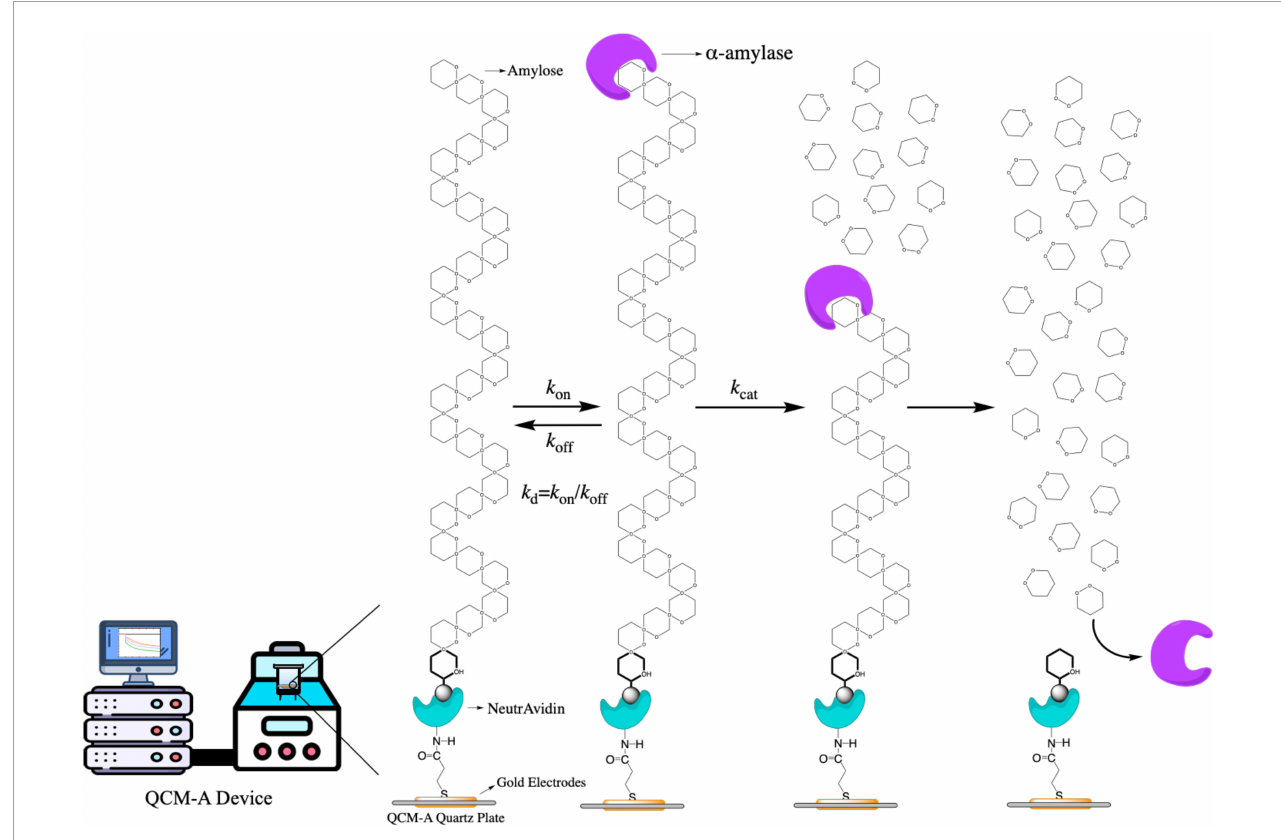
FIGURE1 The scheme of the α -amylase mechanism for amylose hydrolysis and the kinetic parameters obtained in this